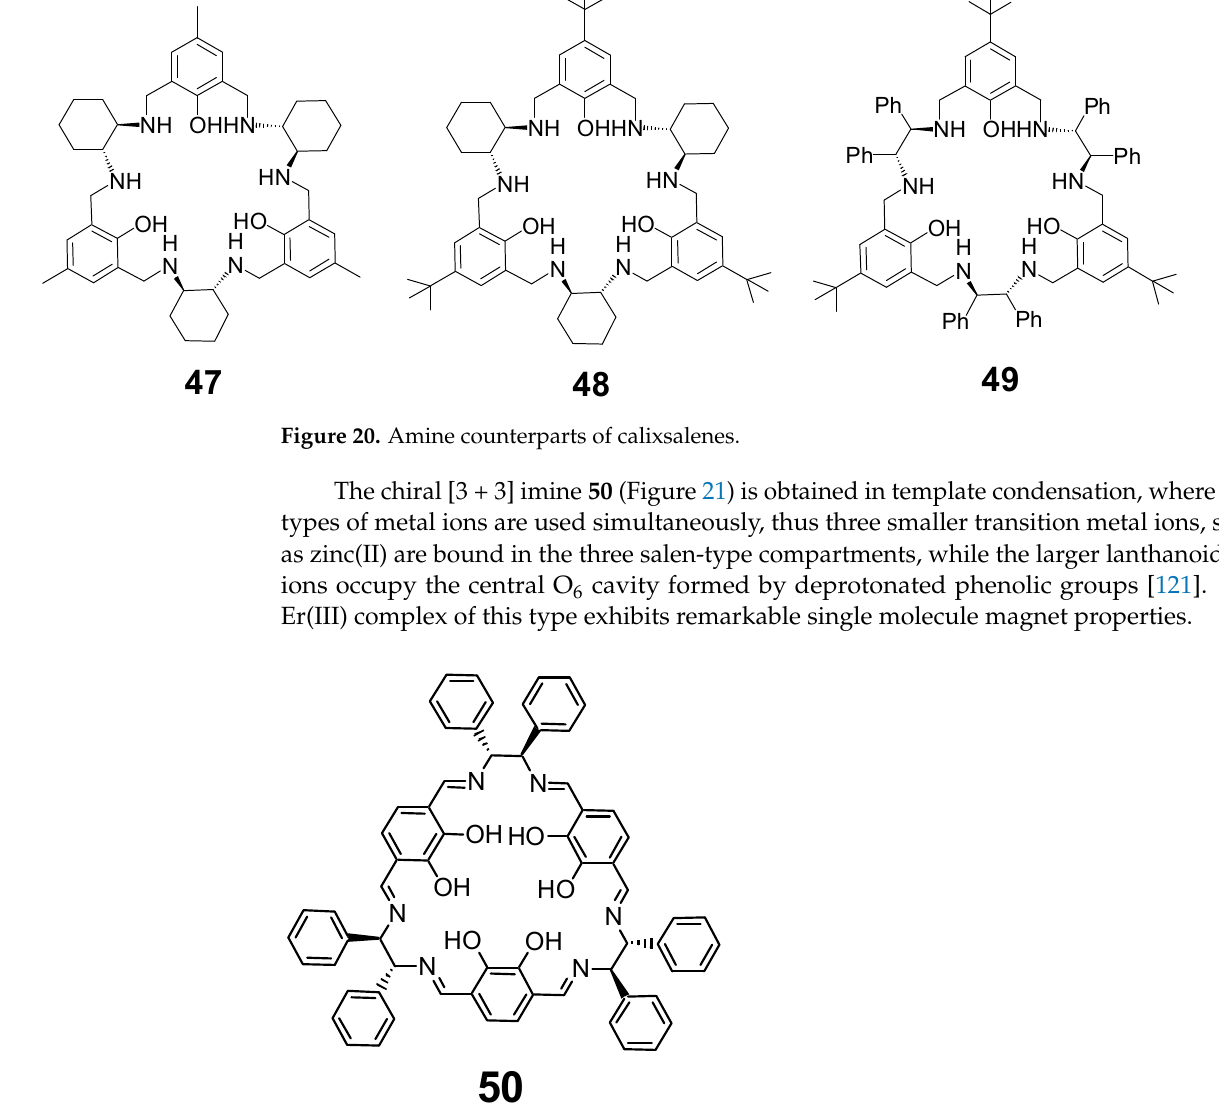
Figure 21. [3 + 3] macrocycle that is obtained in template condensation as a Zn 3 Er complex.